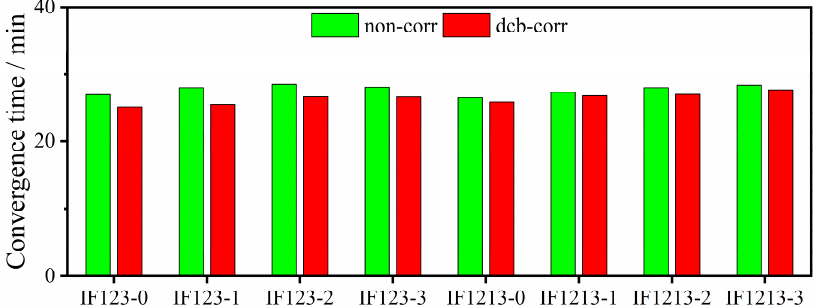
Figure 9. Average convergence time of IF123 and IF1213.